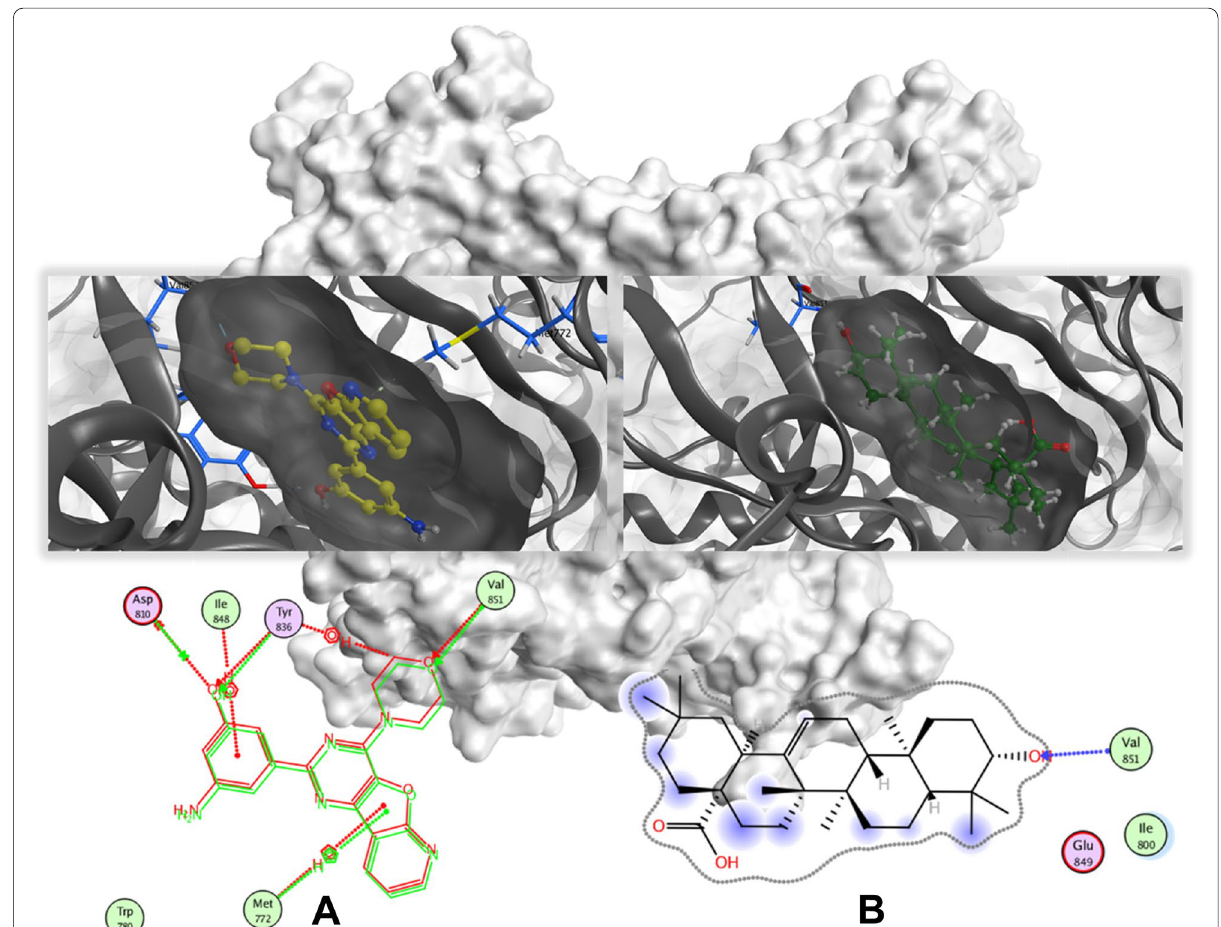
Fig. 5 Visualization of ligand interaction of ( A ) native ligand, XXK (3-amino-5-[4-(morpholin-4-yl)pyrido[3 ′ ,2 ′ :4,5]furo[3,2-d]pyrimidin-2-yl]phenol) and ( B ) OA with p85 (PDB ID: 4L2Y) by using